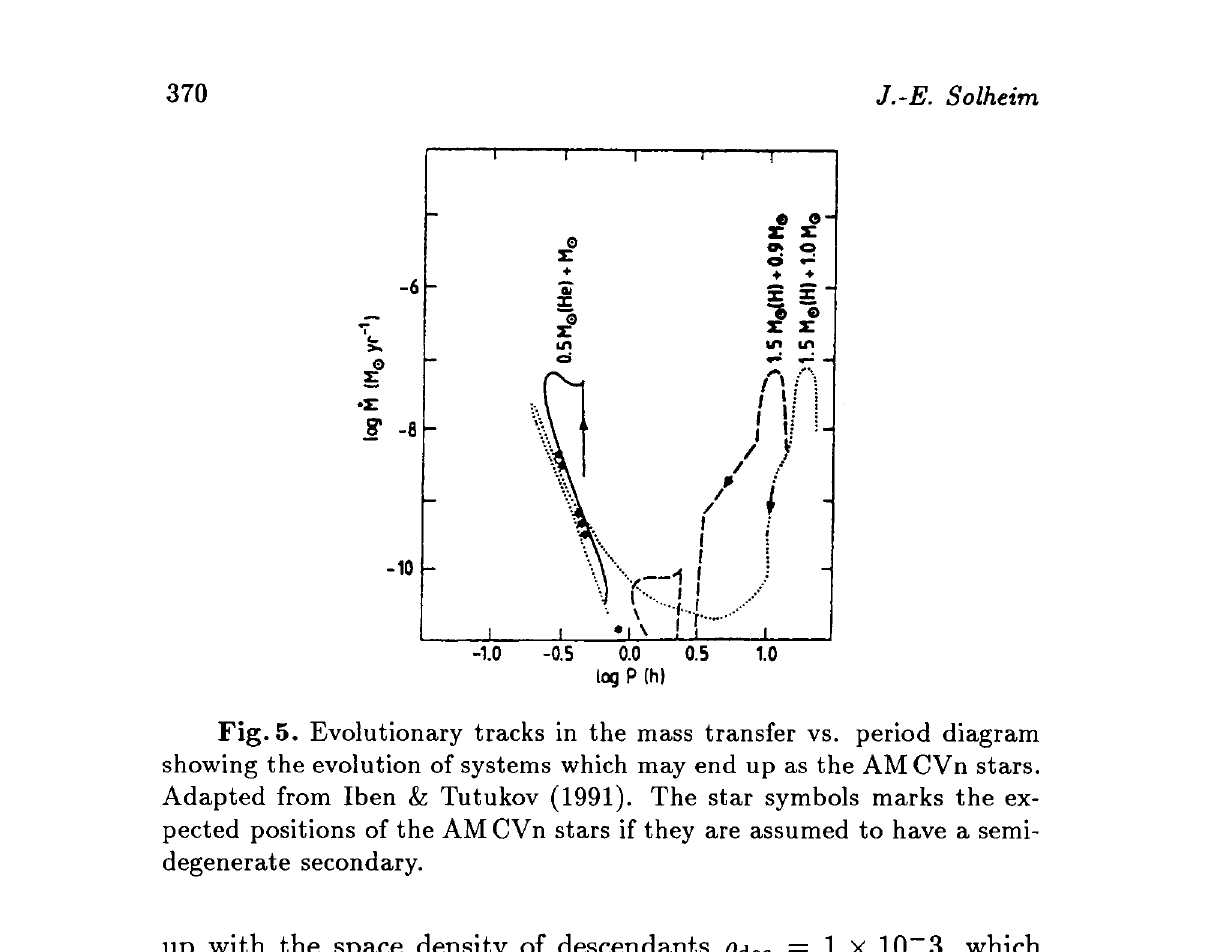
Fig. 5. Evolutionary tracks in the mass transfer vs. period diagram showing the evolution of systems which may end up as the AMCVn stars. Adapted from Iben & Tutukov (1991). The star symbols marks the ex- pected positions of the AMCVn stars if they are assumed to have a semi- degenerate